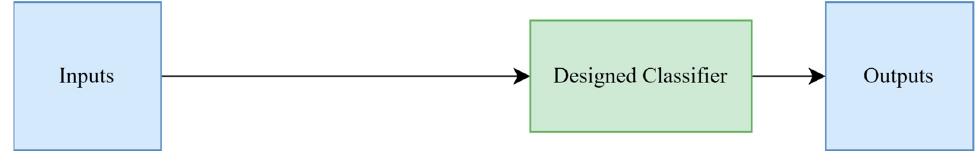
Figure 4. A simple presentation of the classifier without using any pretrained layer.